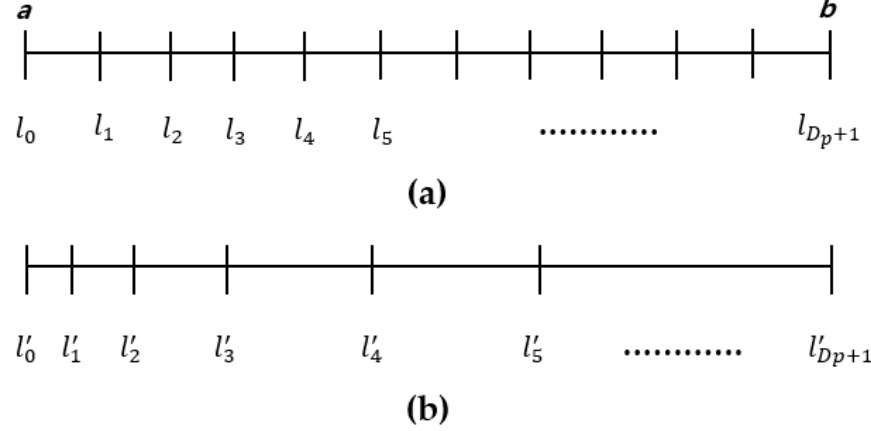
Figure 5. Discretize depth interval [ 𝑎,𝑏 ] into 𝐷𝑝 + 1 subintervals. ( a ) uniformly discretized depth interval and ( b ) discretized depth interval in log space. As the 𝑙 (cid:3036) label approaches the minimum value a , a dense value is reassigned to 𝑙 (cid:3036)(cid:4593) . In contrast, as the 𝑙 (cid:3036) label approaches the maximum value 𝑏 , a coarse value is reassigned to 𝑙 (cid:3036)(cid:4593) .